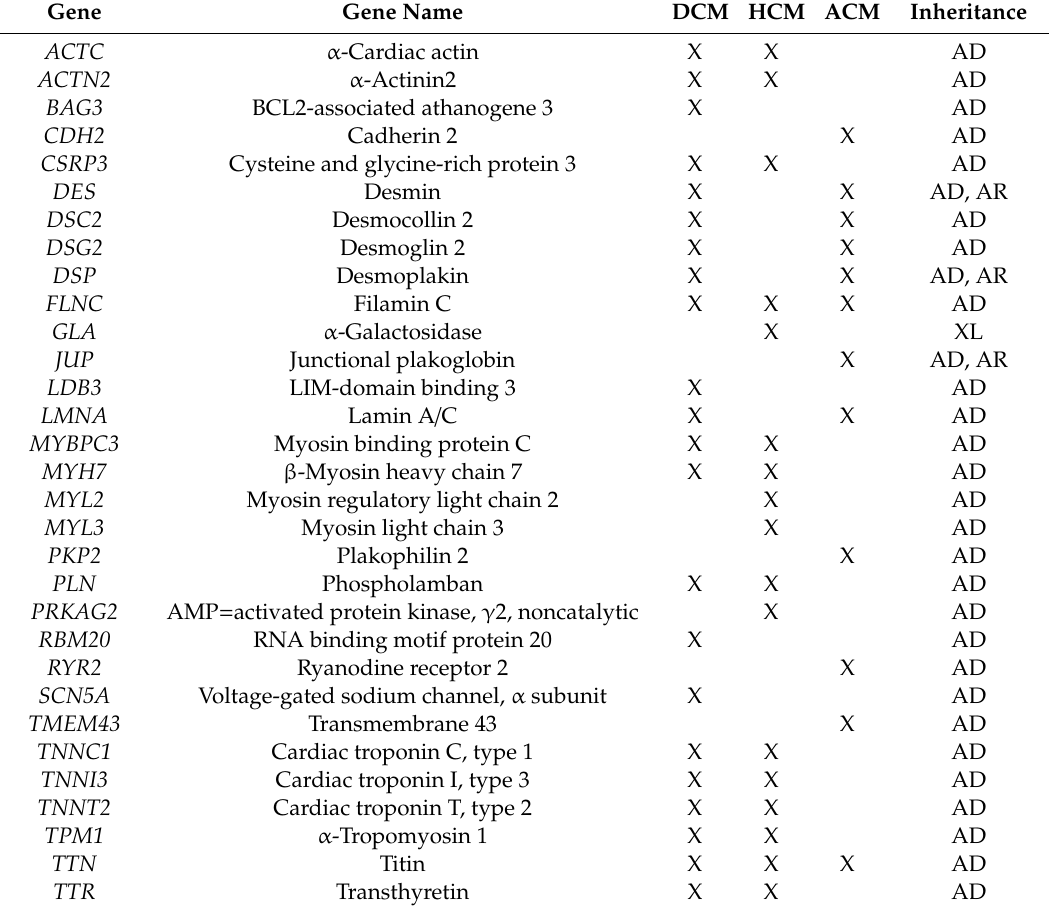
Table 1. Genes Associated with Inherited